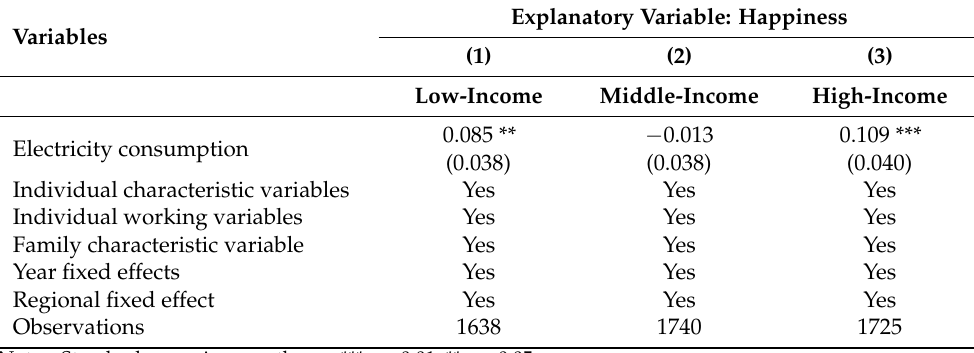
Table 8. Heterogeneity analysis from the perspectives of annual household income.